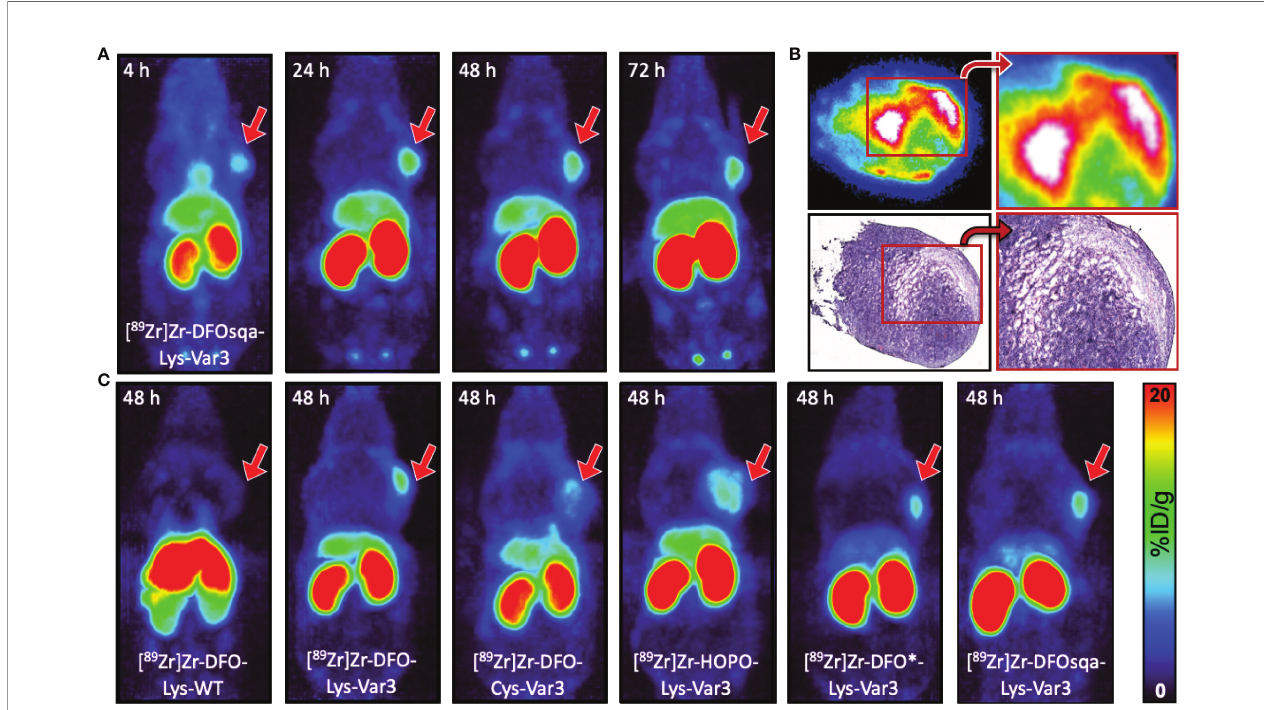
FIGURE 4 | (A) Coronal MIP PET images at 4, 24, 48, and 72 hours offemale athymic nude mice bearing subcutaneous 4T1 tumor allografts on the right shoulder, administered with 7.4 MBq/200 µCi of [ 89 Zr]Zr-DFOsqa-Lys-Var3 (1.2 nmol pHLIP). (B) Ex vivo autoradiograph (top) and H&E staining (bottom) of 10 µm-tumor slices (excised at 72 hours post-injection), not scaled or calibrated. (C) Coronal MIP PET images at 48 hours of male athymic nude mice bearing subcutaneous RM-1 tumor allografts on the right shoulder, administered with 7.4 MBq/200 µCi and 1.2 nmol of the corresponding pHLIP conjugate. The scale bar applies to all PET